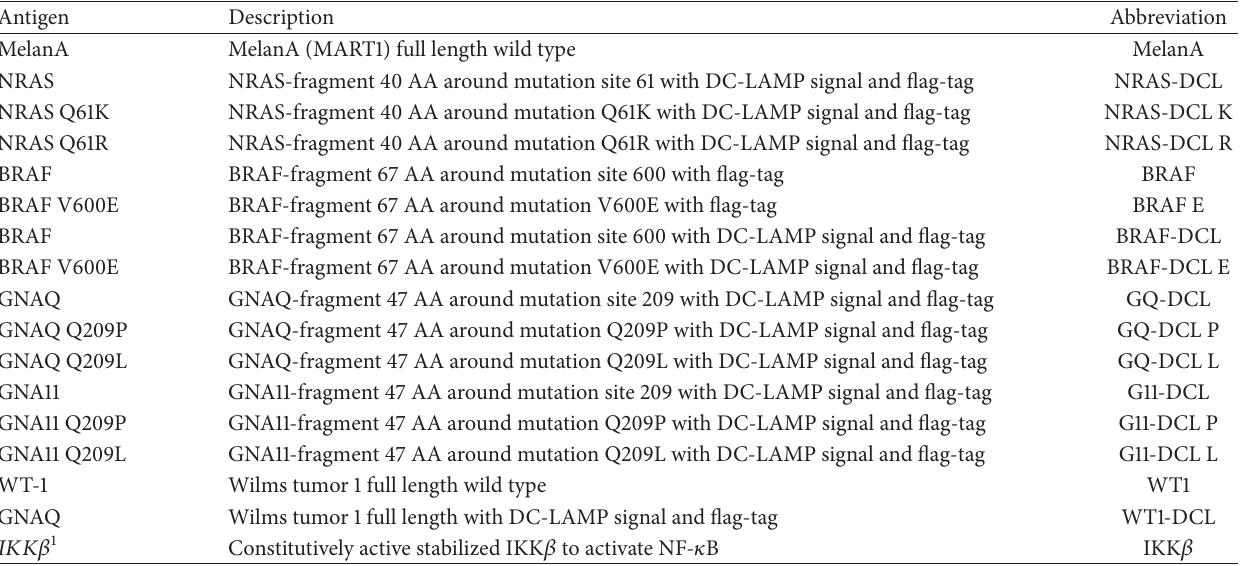
Table 1: mRNAs used for